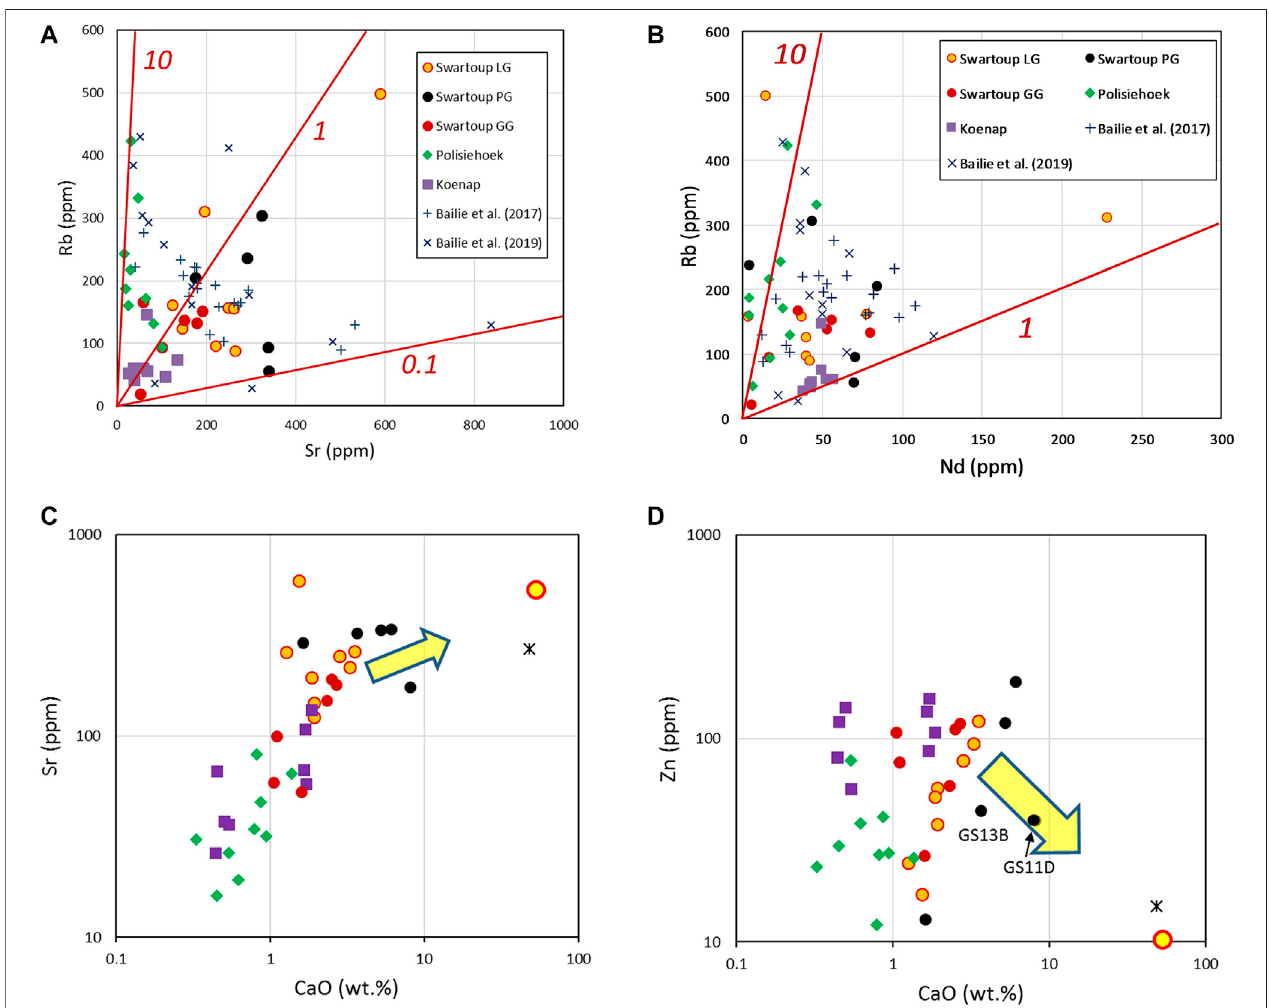
FIGURE 11 | Variation ofRb vs. (A) Rb vs. Sr and (B) Rb vs. Nd, for the Swartoup Hills granitoids and migmatite, as well as the granitoids of Bailie et al. (2017) and Bailieetal.(2019).LinesofconstantRb/SrorRb/Ndratioareshowninred,withvaluesindicated.In (C) CaOvsSrand (D) CaOvs.Zndataareplotted,withreferencetoa sample of the Bysteek Formation marble (plotted as an asterisk) and average back-arc limestones (yellow symbol; Zhang et al., 2017). The arrows indicate direction of mixing from an average Swartoup granitoid toward the carbonate compositions.